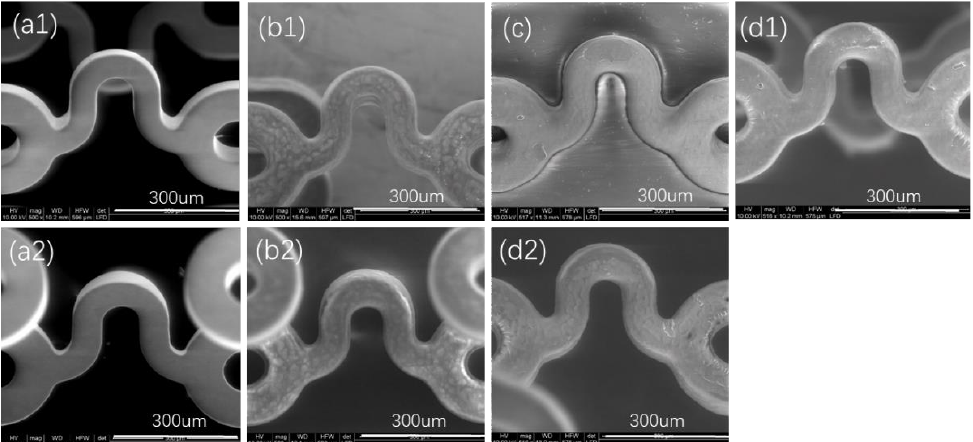
Figure 3. Morphologies of coating surfaces made by P34HB-1. ( a1 ) Outer surface of a bare stent; ( b1 ) outer surface of a drug stent; ( c ) outer surface of a drug stent at squeezed state; ( d1 ) outer surface of a drug stent after expansion; ( a2 ) inner surface of a bare stent; ( b2 ) inner surface of a drug stent; ( d2 ) inner surface of a drug stent after expansion.